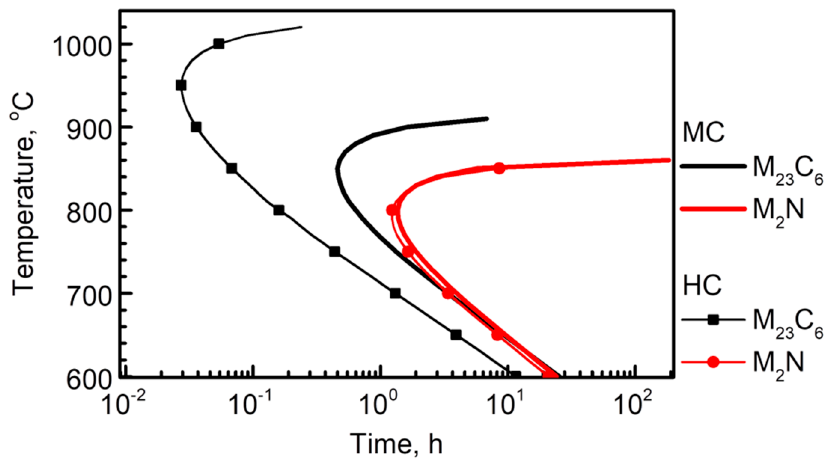
Figure 6. Time-temperature-precipitation diagram for M 2 N and M 23 C 6 in the MC and HC alloys calculated by JMatPro Software.